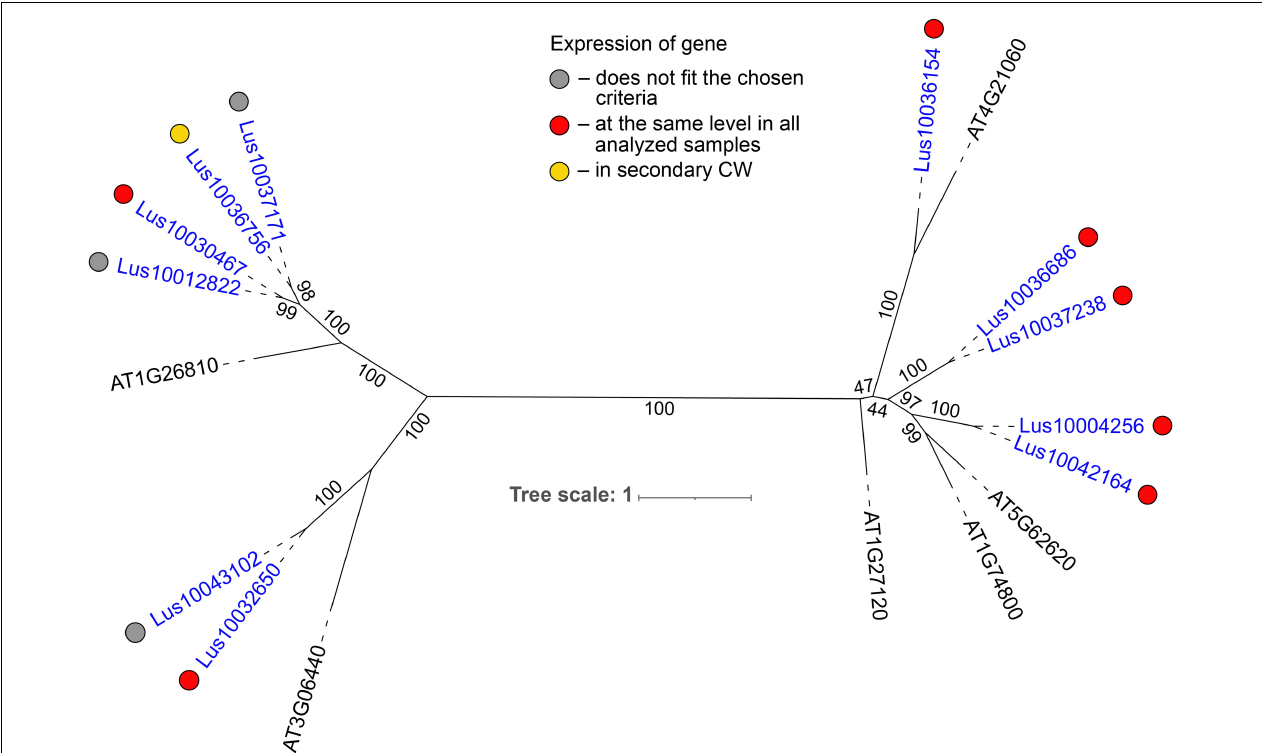
FIGURE 5 | Phylogenetic dendrogram of galectin–like (PF00337) domain-containing glycosyltransferases from family 31 of Arabidopsis thaliana and Linum usitatissimum . The A. thaliana gene names are given in black font; additional gene names are given according to descriptions in the Uniprot database (https://www.uniprot.org/; The UniProt Consortium, 2019). L. usitatissimum gene names are given in dark blue font. The numbers in parentheses reflect the number of predicted transmembrane domains according to TMHMM v2.0 prediction tool (http://www.cbs.dtu.dk/services/TMHMM/; Krogh et al., 2001). The different colored dots next to L. usitatissimum gene names indicate genes with different expression patterns. The criteria used for different expression pattern identification as follow: red, the mean values of tau-score < 0.15 across all samples; yellow, DEGs upregulated in samples with secondary CW. Flax genes with red and yellow dots are listed in Tables 2 , 4 , respectively. Gray dots indicate genes where the expression does not fit the chosen criteria (tau-score < 0.15 or DEGs) for a certain expression pattern (expression values for these genes are given in Supplementary File 3 ). Numbers indicate the ultrafast bootstrap support values for some branches. Abbreviations: DEGs – differentially expressed genes, a pairwise comparison log 2 FC ≥ 1, padj ≥ 0.01, CW, cell